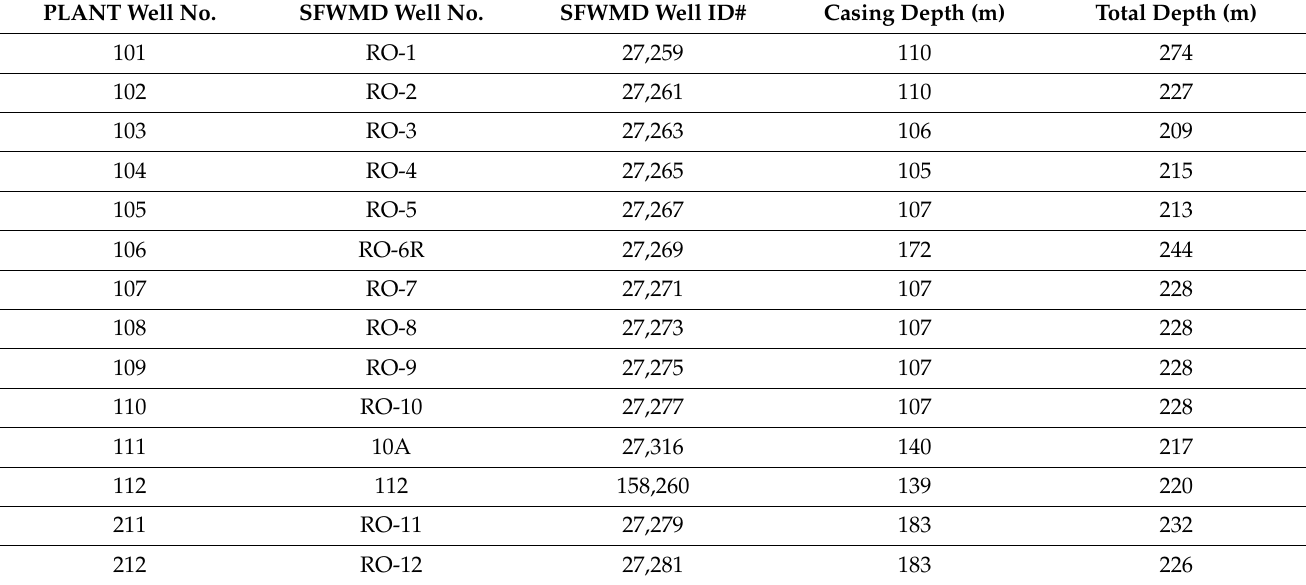
Figure 3. Map showing the location of production wells. Table 1. South Wellfield construction details (City of Cape Coral 2021). PLANT Well